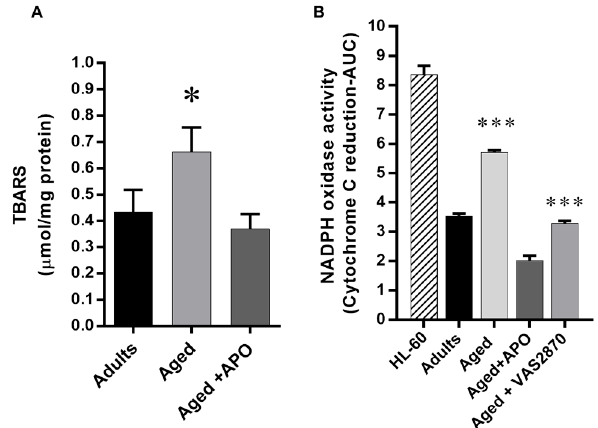
Figure 5. Oxidative Stress. NOX-derived oxidative stress was investigated by two methods. Upper panel, Western blot for p47phox, one of the activating subunits of NOX2, in adults ( n = 4) and aged hearts (4) and the quantification normalized to GAPDH levels (mean ± standard deviation). ( A ) The graph depicts the concentration (mean ± SEM) of thiobarbituric acid (TBARS), a marker of lipid peroxidation, in cardiac homogenates from adult ( n = 4), aged ( n = 5), and aged hearts treated with apocynin (APO) 100 µ mol/L ( n = 5). ( B ) NADPH oxidase activity assessed as cytochrome c reduction. The graph depicts the reduction of cytochrome c, activity over time is shown as area under the curve (AUC) in cardiac homogenates from adults ( n = 3), aged ( n = 3), aged treated with apocynin 100 µ mol/L (APO, n = 4), and aged hearts treated with VAS2870 (20 µ mol/L, n = 4). * p < 0.05 vs. adult and aged plus apocynin, HL-60 cells were used as positive control. *** p < 0.05 vs. all the other